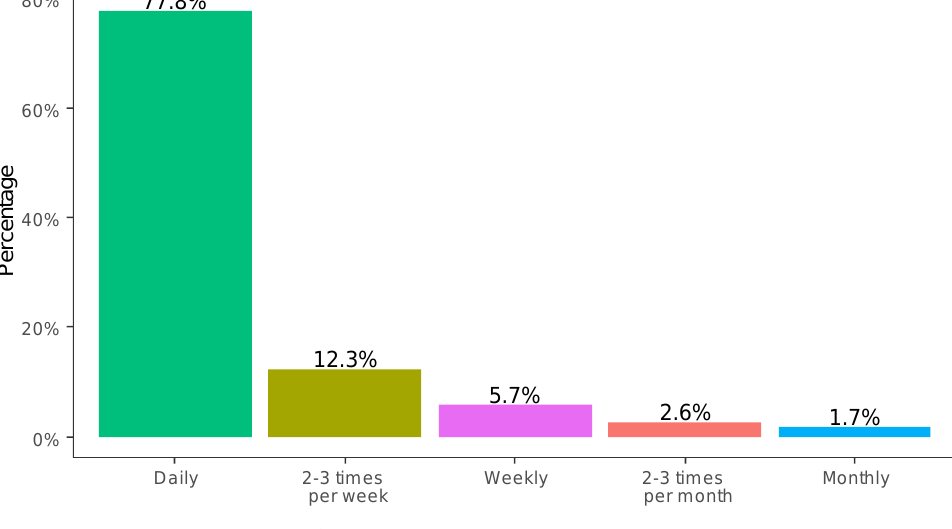
Figure 2. Internet Usage Frequency among